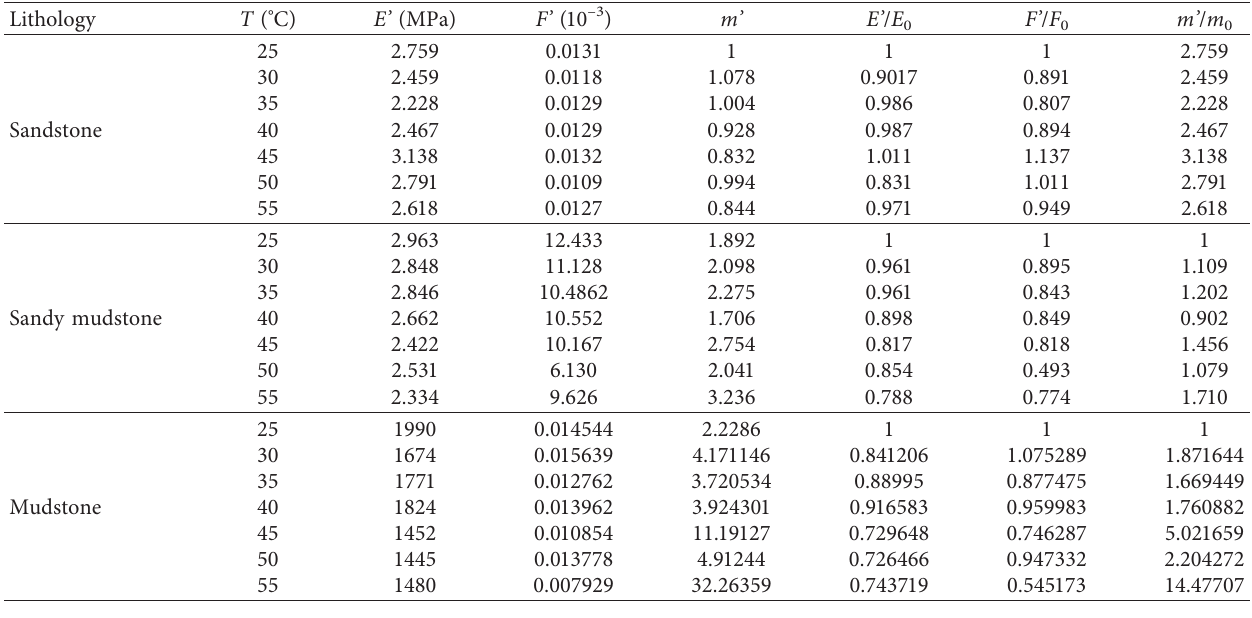
Table 2: The ratio of E ′ , F ′ , and m’ at test temperature to room temperature.